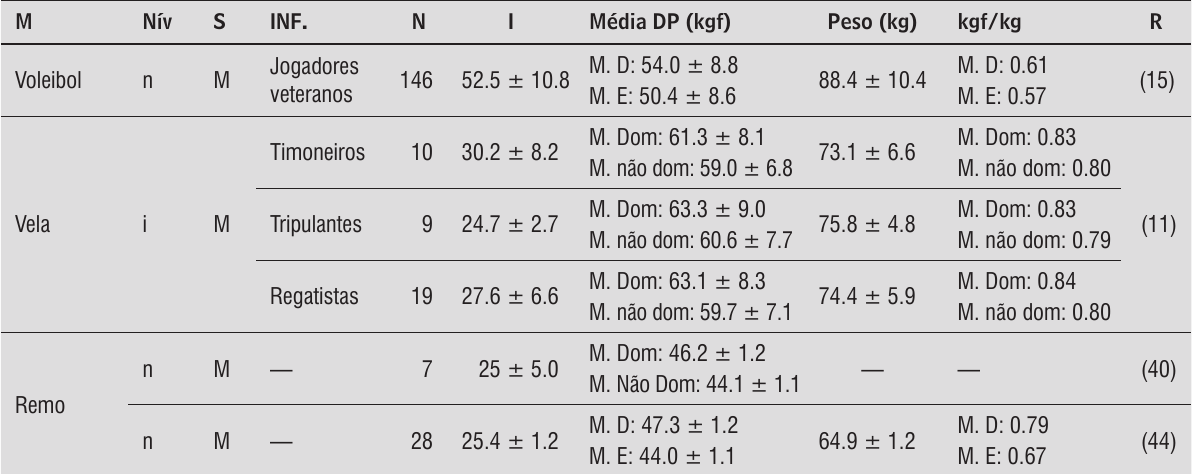
Tabela 2 - Valores da força de preensão manual em diferentes tipos de modalidades